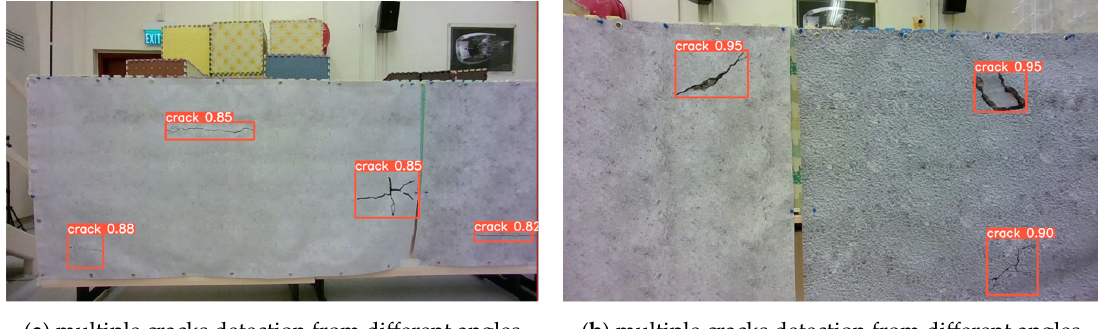
Figure 17. Multiple cracks detection performance in the laboratory environment.